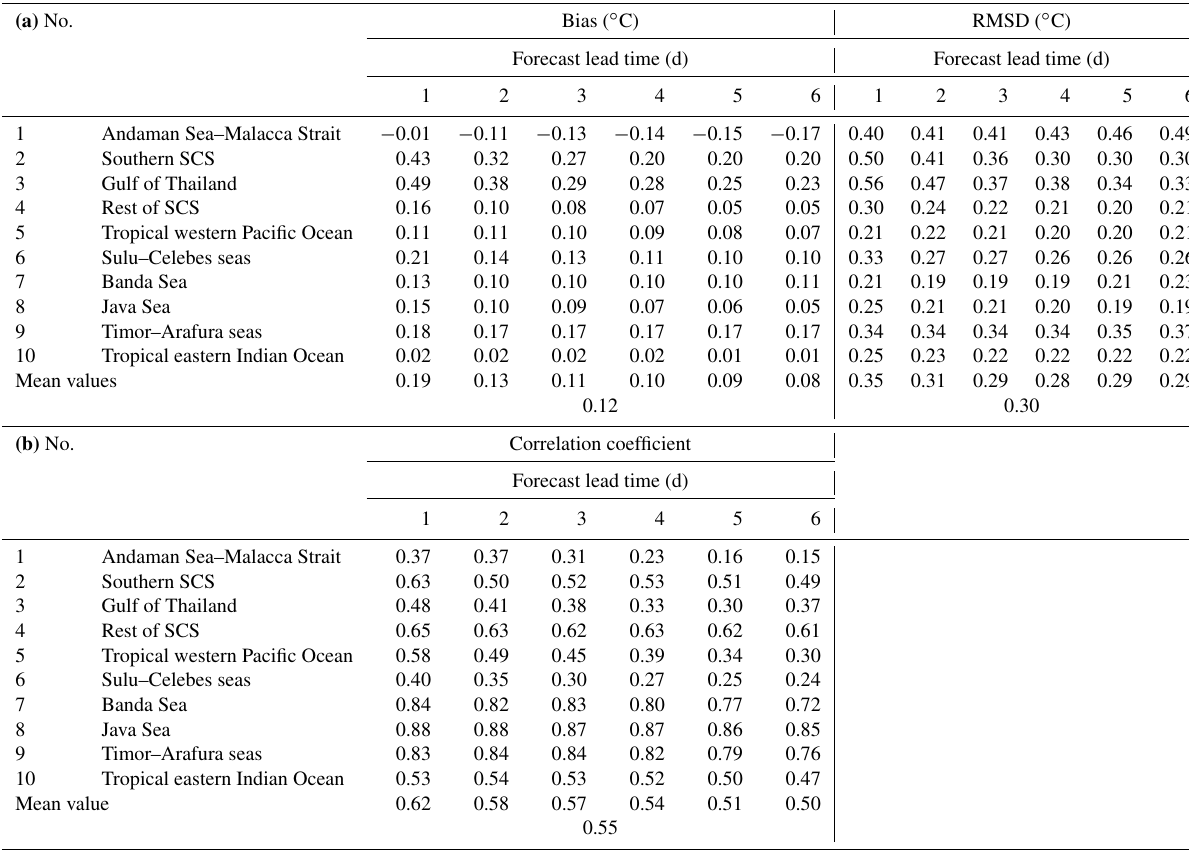
Table 4. Summary of SST bias and RMSD (a) and correlation coefficient (b) statistics between coupled ocean forecasts and OSTIA over the sub-regions shown in Fig. 3 from 1 to 31 October 2019. Daily mean SST from model and OSTIA is used for the analysis. (a) No.